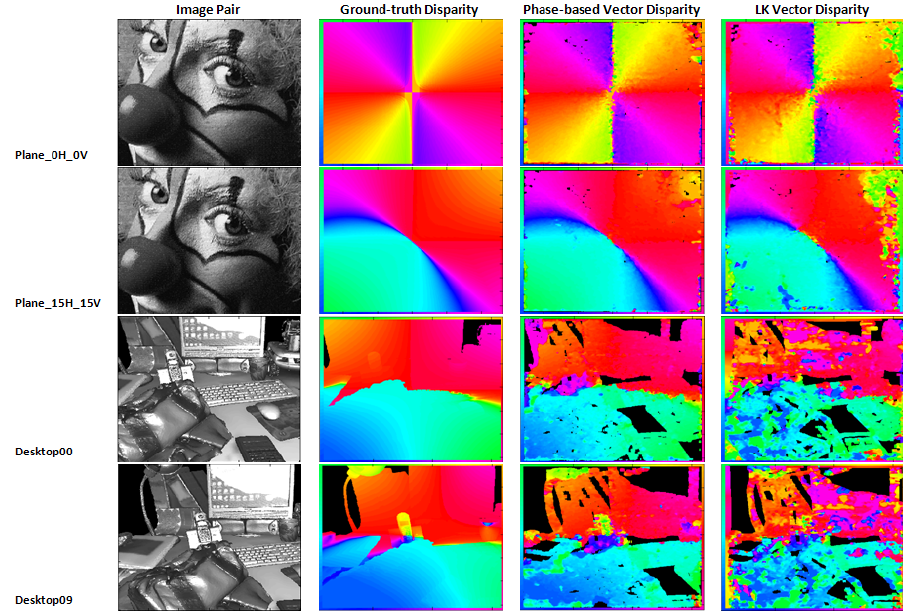
Figure 9. Software benchmark results for vector disparity. From left to right: original image, ground-truth, software results for phase-based, and Lucas–Kanade algorithms. The frame codes the vector disparity with a color.